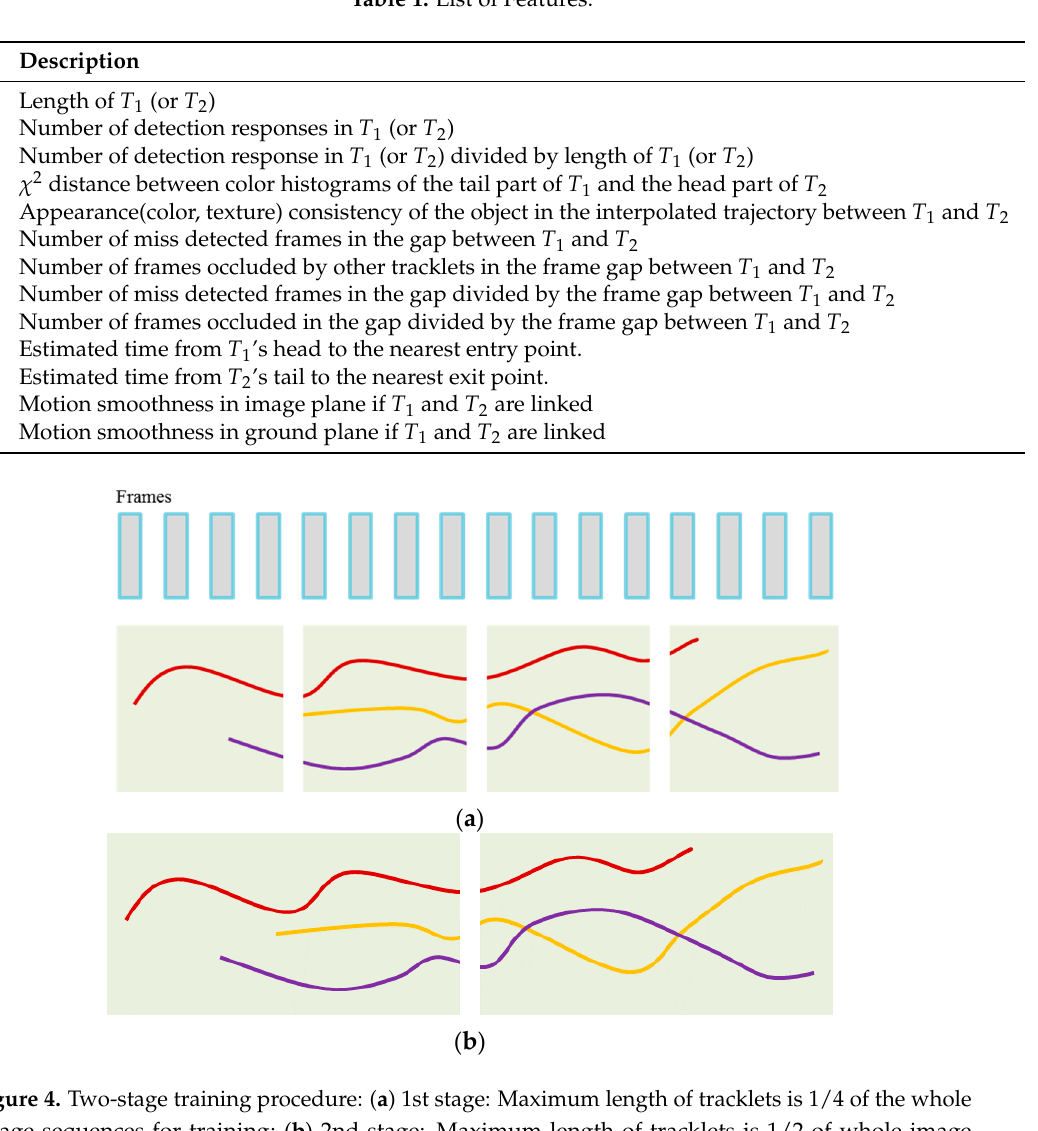
Table 1. List of Features.